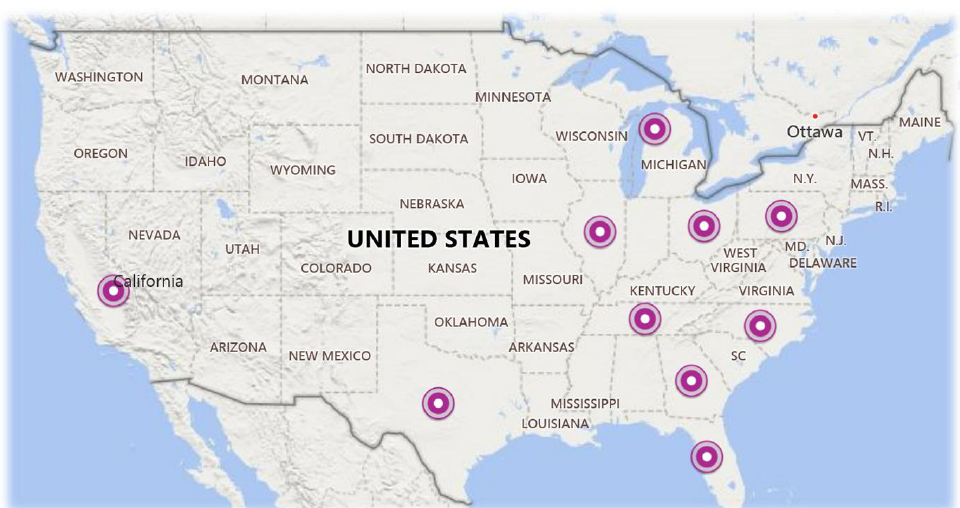
Figure 1. Top Ten States in Terms of Crashes.